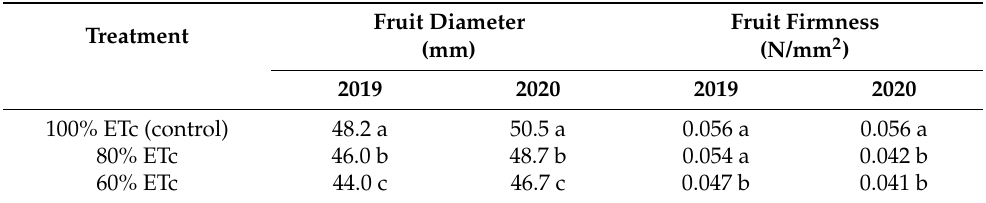
Table 5. Effect of deficit irrigation (as a percentage of crop evapotranspiration, ETc) on fruit size and firmness of ‘African Rose’ plum trees during the 2019 and 2020 seasons ( n = 10).